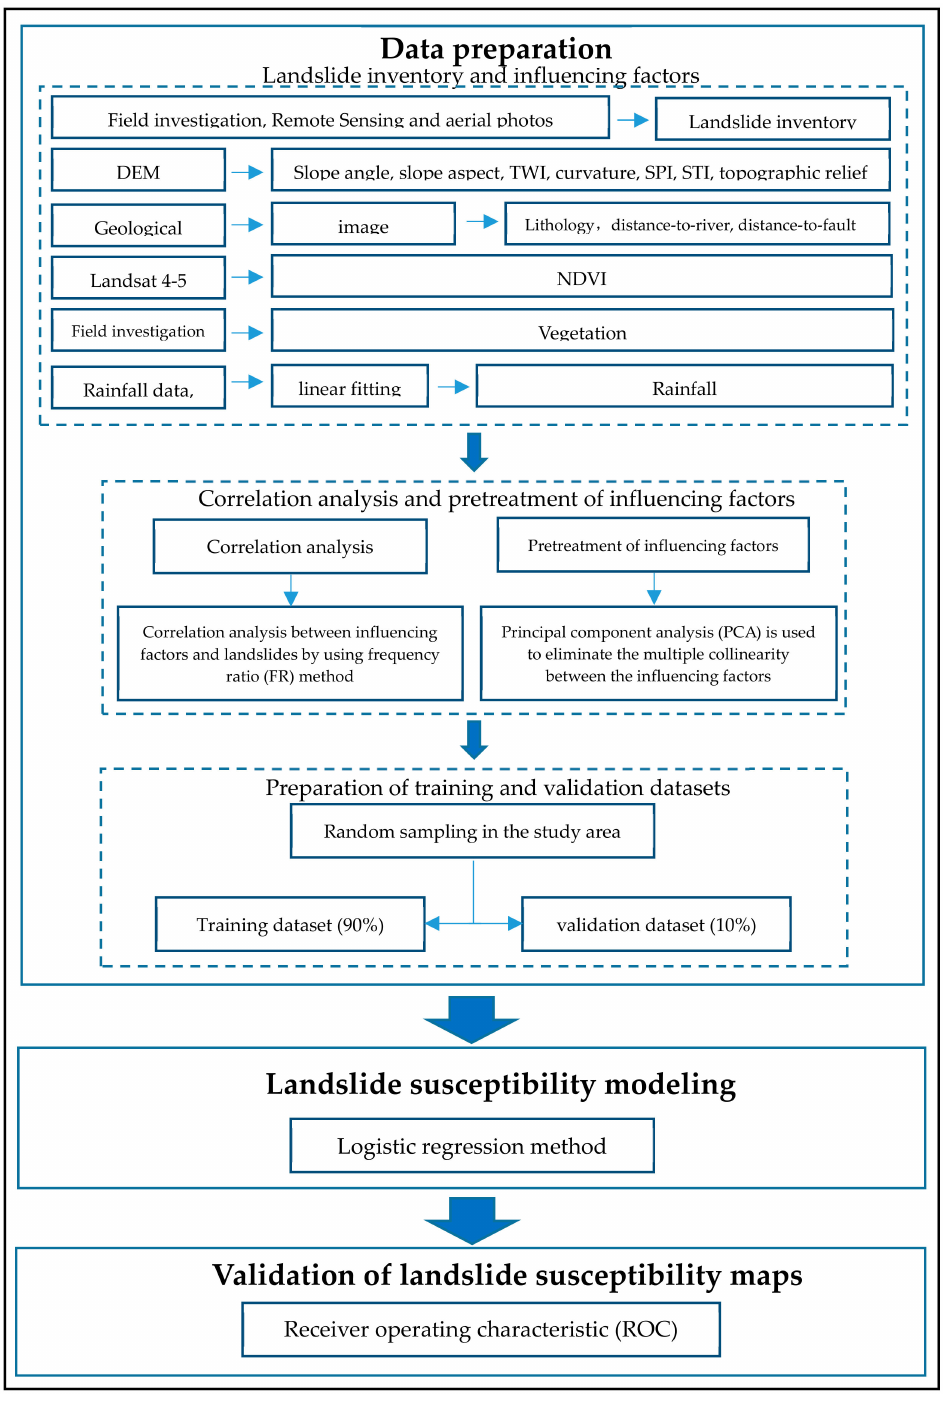
Figure 2. Flow chart of this